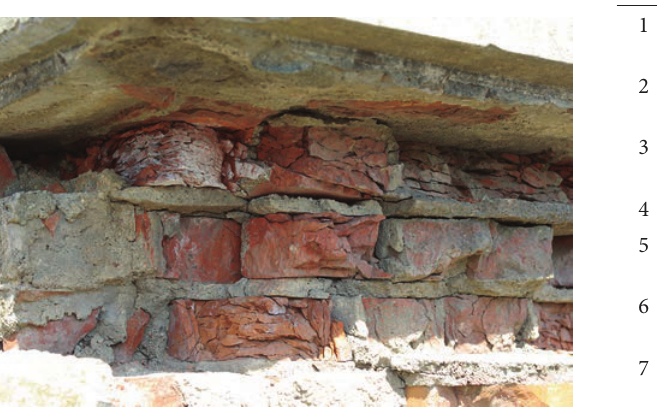
Fig. 9. Disintegrated bricks due to incorrect cladding material selection